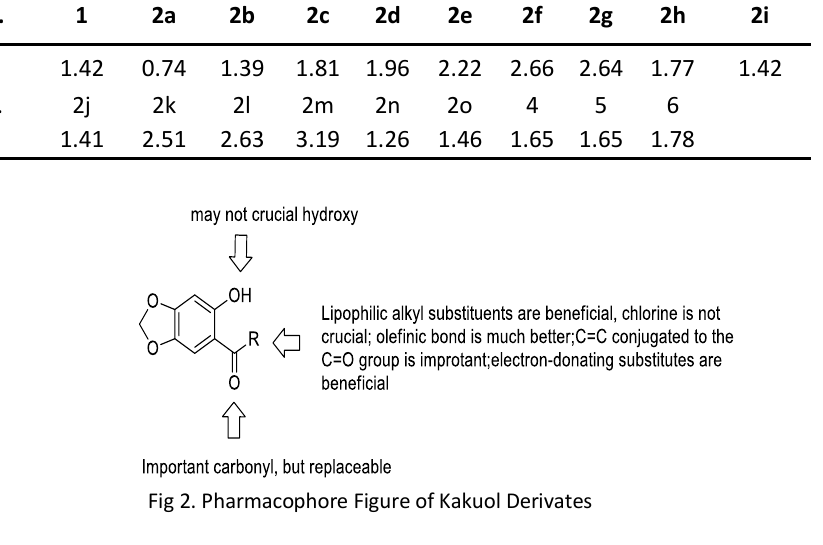
Table 2. The lipophilicity values of the compounds 1–6 Compd.